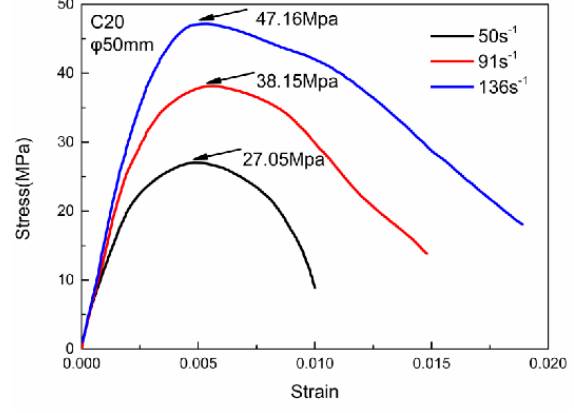
Figure 3. Typical stress–strain curves of RCC specimens.